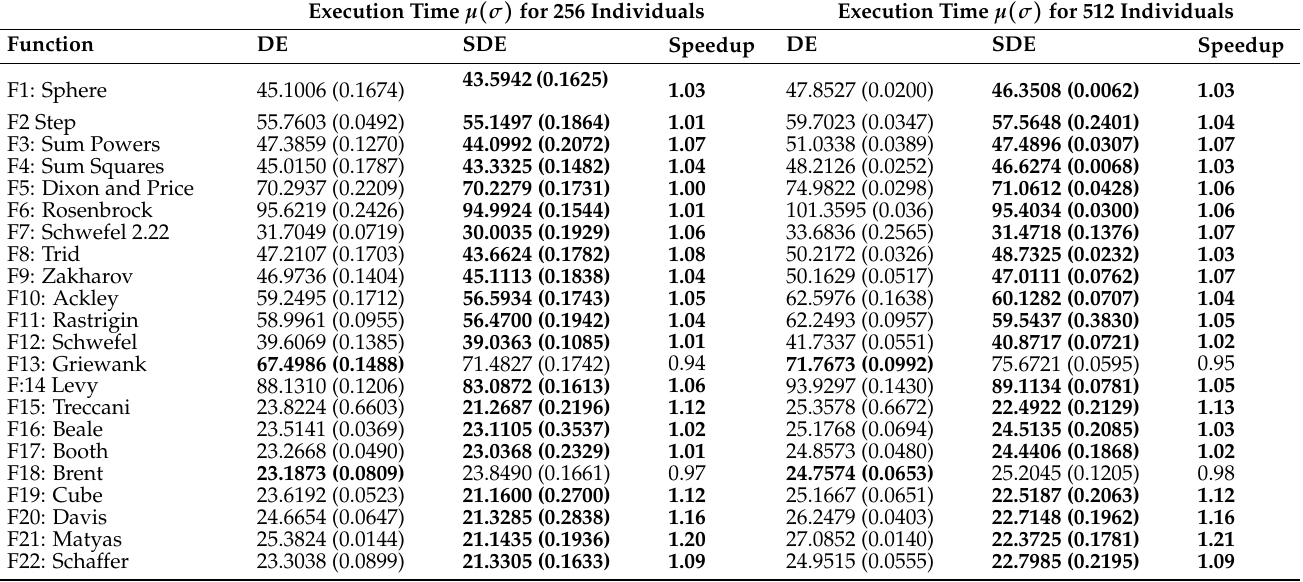
Table 6. Mean and averaged execution times in seconds of DE and SDE ( D =